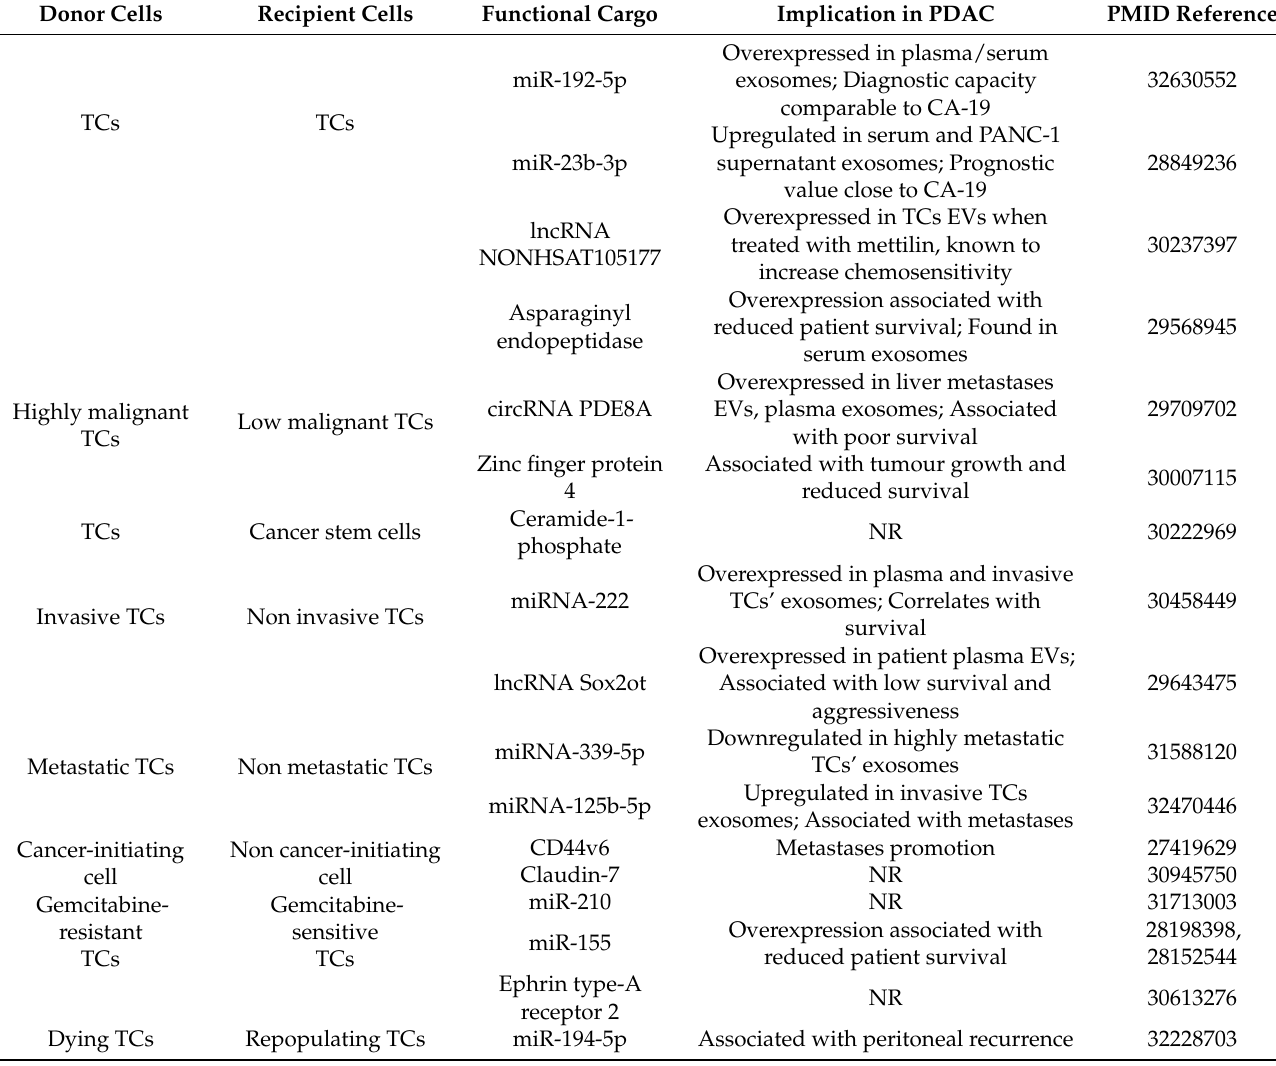
Table 1. Tumor to tumor cell crosstalk mediated by